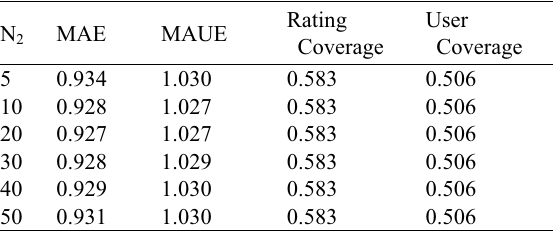
Table 3. Determine the optimized value of